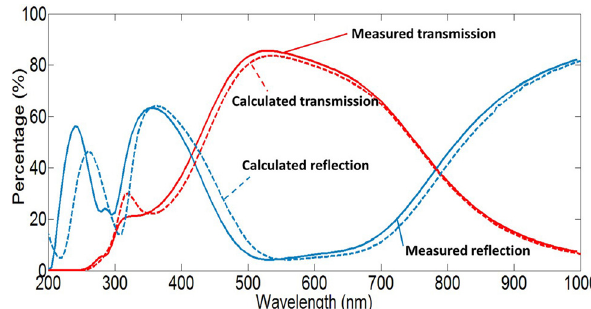
Figure 3: Comparison between the modelled data based on the transfer matrix method and the measured data for the transmission and reflection of the glass substrate uniformly coated with the designed m-DM stack (DMDMD) on one side where the total Ag thickness is 30 nm and the respective thicknesses of 42 nm-15 nm- 48 nm-15 nm-42